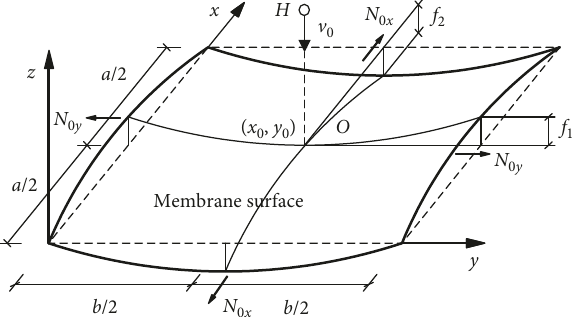
Figure 1: Pretensioned orthotropic saddle membrane model under an impact load with four edges simply